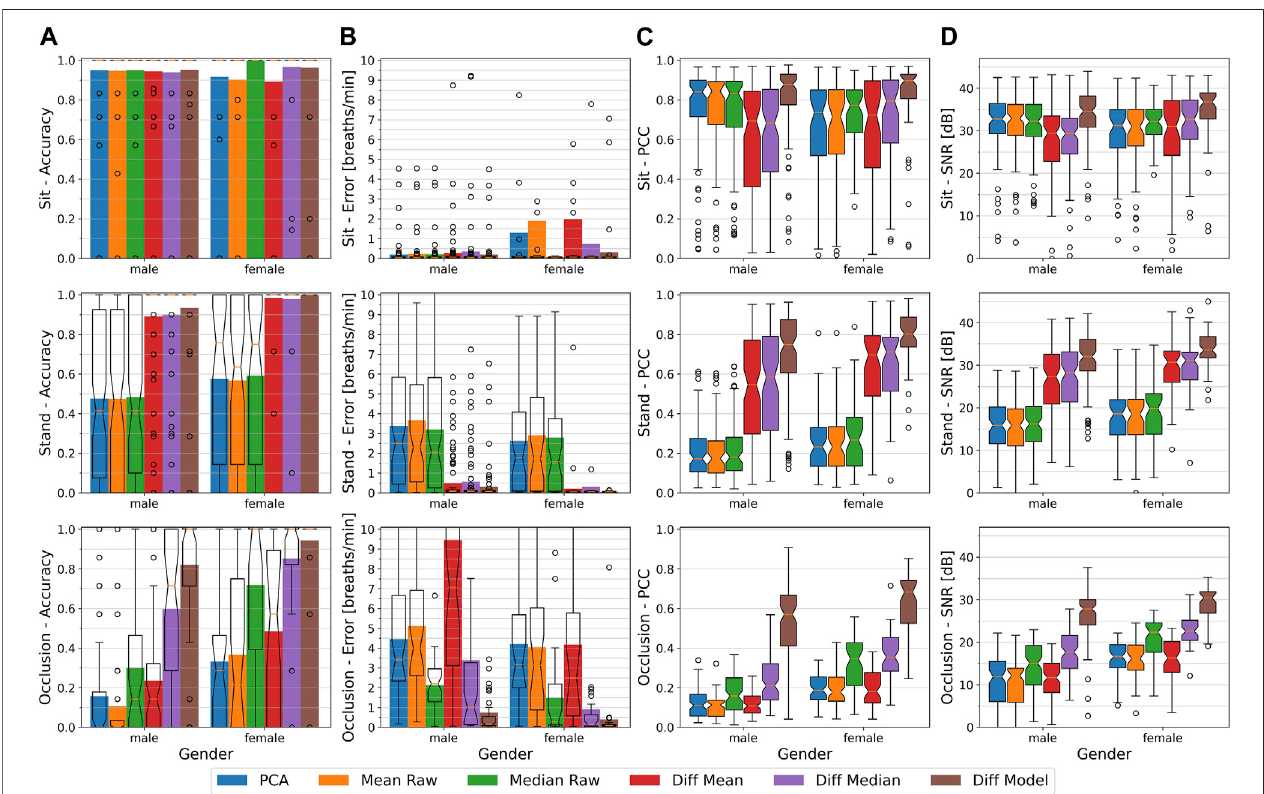
FIGURE9| From (A – D) :Therespiratoryrateaccuracy,errorsinbreathperminute,PearsonCorrelationCoef fi cientw.r.t.thegroundtruthsignal,andsignaltonoise ratioofthedifferentmethods at thechest. Plotsare separated fromtop tobottombythe sitting, standing, and occlusion conditionand bythegender ofthe participants, withalldistances(1 – 4 m)andallrespiratoryrates(10and15 bpm)combined.AccuracyanderrormetricsuseaFastFourierTransformwindowwithalengthof48 s.The colored bars show the averages, while overlay box plots show median (middle parts) and whiskers marking data within 1.5 IQR. Except for the sitting condition, all considered methods perform signi fi cantly better on the female participants, mostly due to unbalanced group sizes (12 male, 7 female) and highly variable results for the male participants (user 9, male, had problems in adhering to the breathing visualization, also see Sec. 5.7 ).